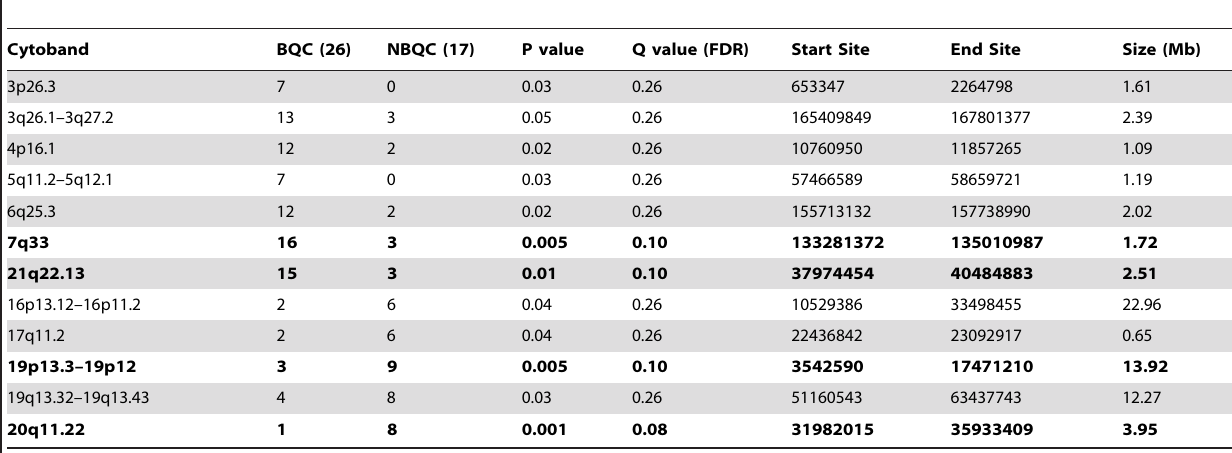
Table 1. Chromosomal areas with gain those are significantly different between betel quid chewers (BQC) and non betel quid chewers (NBQC) breast cancer patients.